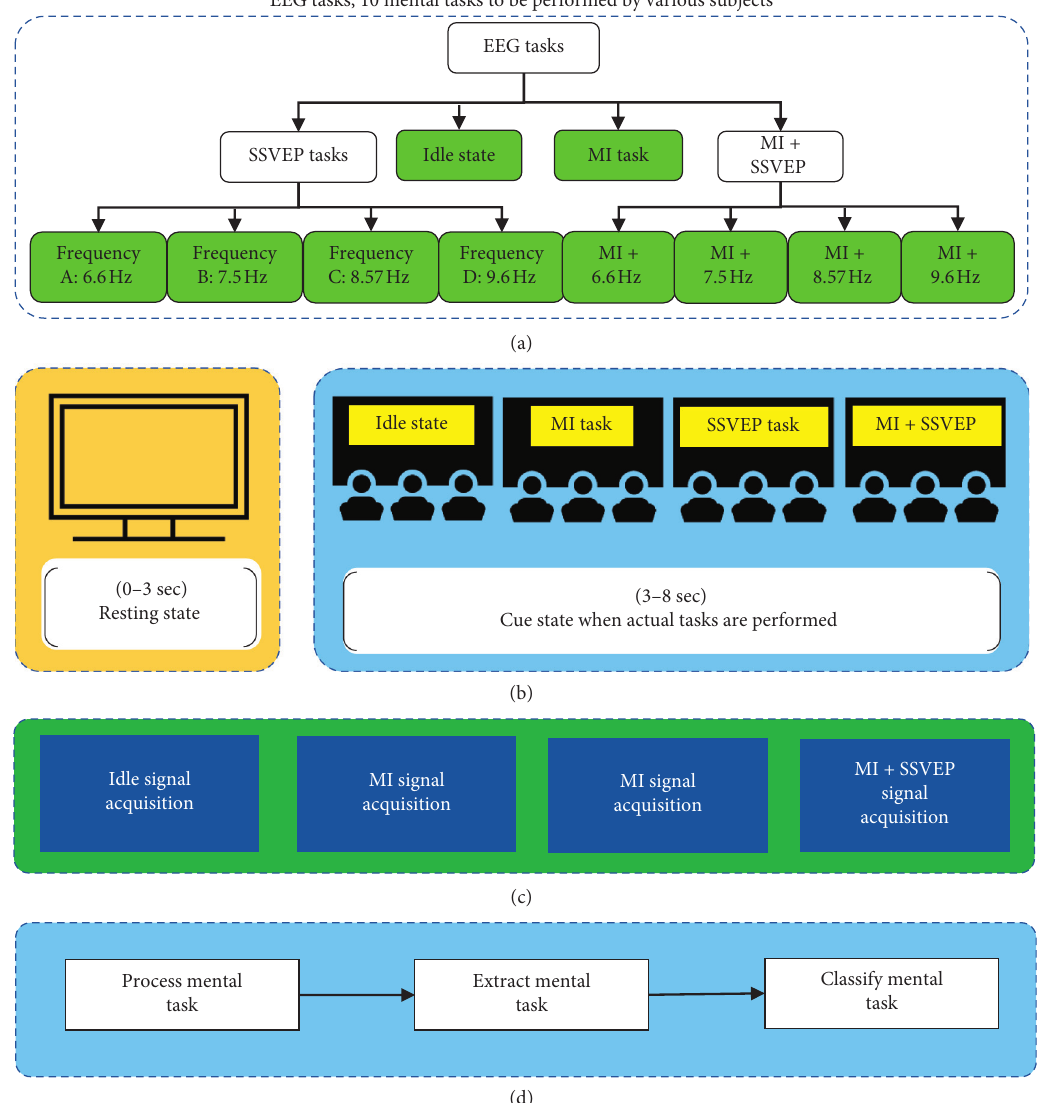
Figure 2: Graphical user interface for the hybrid BCI system. (a) The caption EEG tasks shows the 10 mental tasks to be performed, which include idle state, MI task, SSVEP task, Freq. A-SSVEP task, Freq. B-SSVEP task, Freq. C-SSVEP task, Freq. D-SSVEP task, MI +Freq. A- SSVEP task, MI+Freq. B-SSVEP task, MI+Freq. C-SSVEP task, and MI+Freq. D-SSVEP task. (b) Time window for the performance of tasks divided into 2 parts for clarification, 0–3s (rest state time) and 3–8s (task-performing window). (c) Signal acquiring from the above performed tasks. (d) Processing, extraction, and classification of signals.